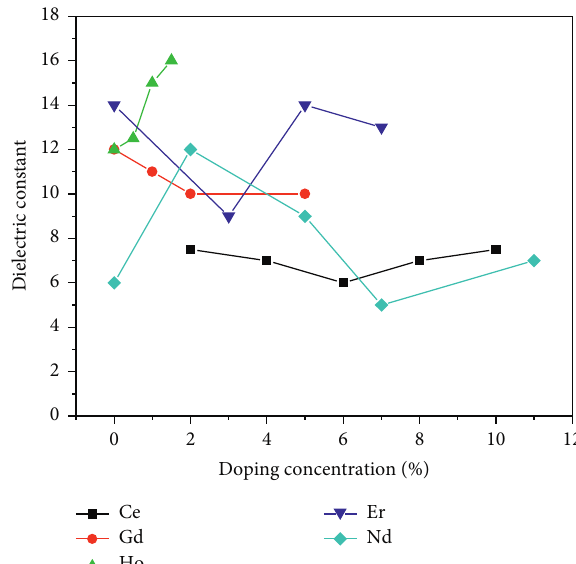
Figure 9: Variation of dielectric constant of rare earth metal-doped ZnO nanoparticles with respect to doping concentration at 1MHz